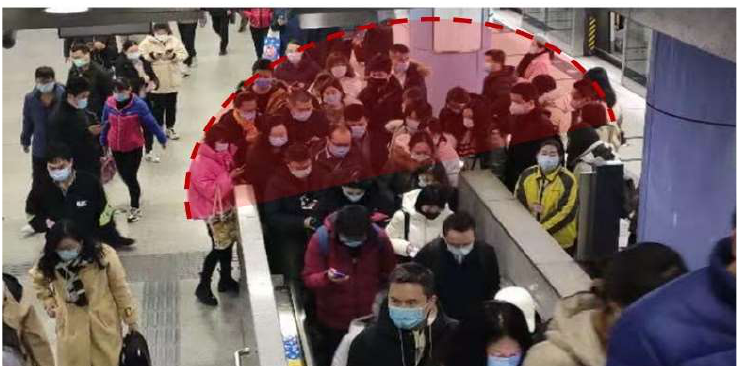
Figure 1. Pedestrian arching at bottleneck in subway transit hub.